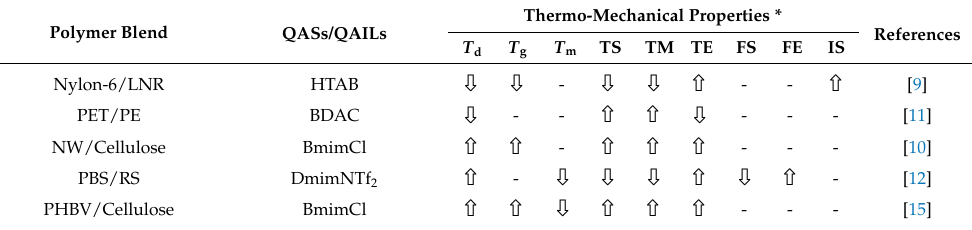
Table 7. Thermo-mechanical properties of polymer blends influenced by QASs and QAILs. T d = degradation temperature, T g = glass transition temperature, T m = melting temperature, TS = tensile strength, TM = tensile modulus, TE = tensile extension, FS = flexural strength, FE = flexural extension, and IS = impact strength. * The symbol “ ⇧ ” corresponds to an increase in the properties and “ ⇩ ” a decrease in the properties while “-” describes not available.